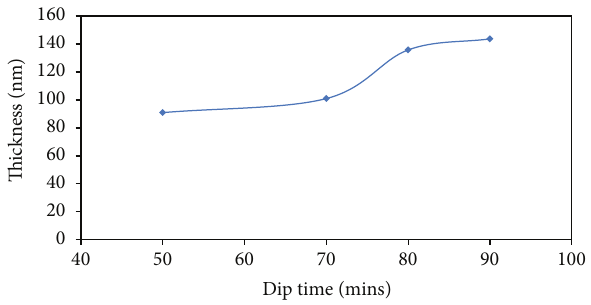
Figure 9: Thickness of the deposited film.